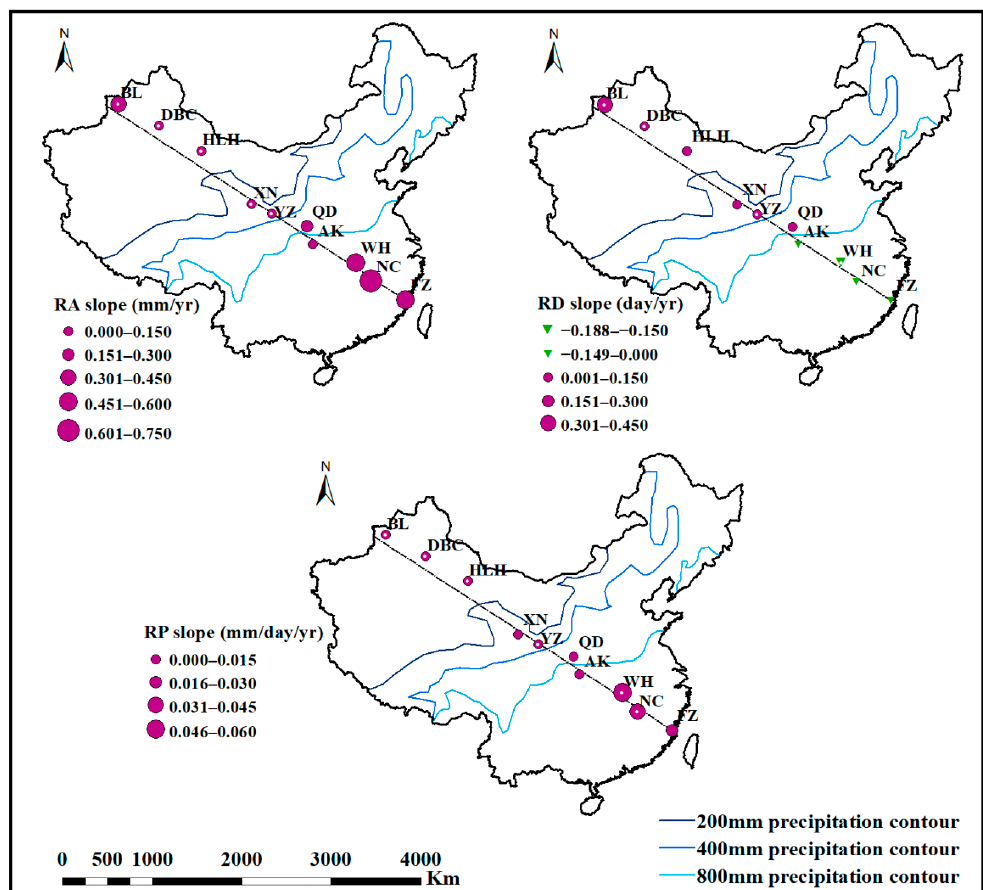
Figure 6. The Mann-Kendall trend test and Sen’s slope were used to reflect the variation trends for the winter precipitation indices, including rainfall amount (RA), rainfall days (RD), and daily precipitation on rainy days (RP). Note: white spots mean precipitation change trend reached the significance level of 95% confidence for the MK trend test. 95% confidence for the MK trend